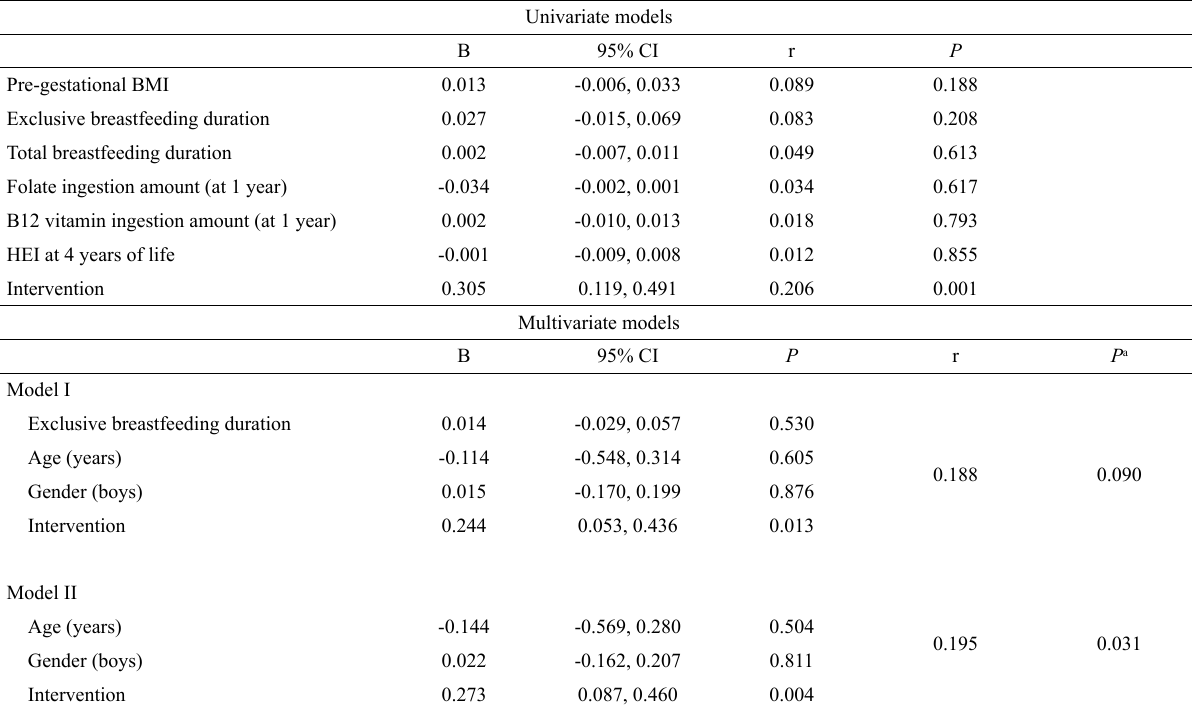
Table 4 – Linear regressions between environmental factors and global DNA methylation in